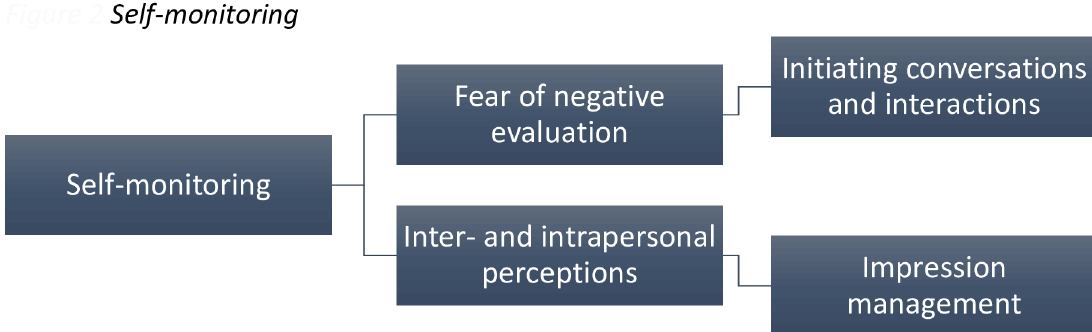
Fig 2. The furthest left hand box indicates the superordinate themes, with the subordinate themes in the remaining boxes. The connecting lines indicate the hierarchical organisation of the themes.